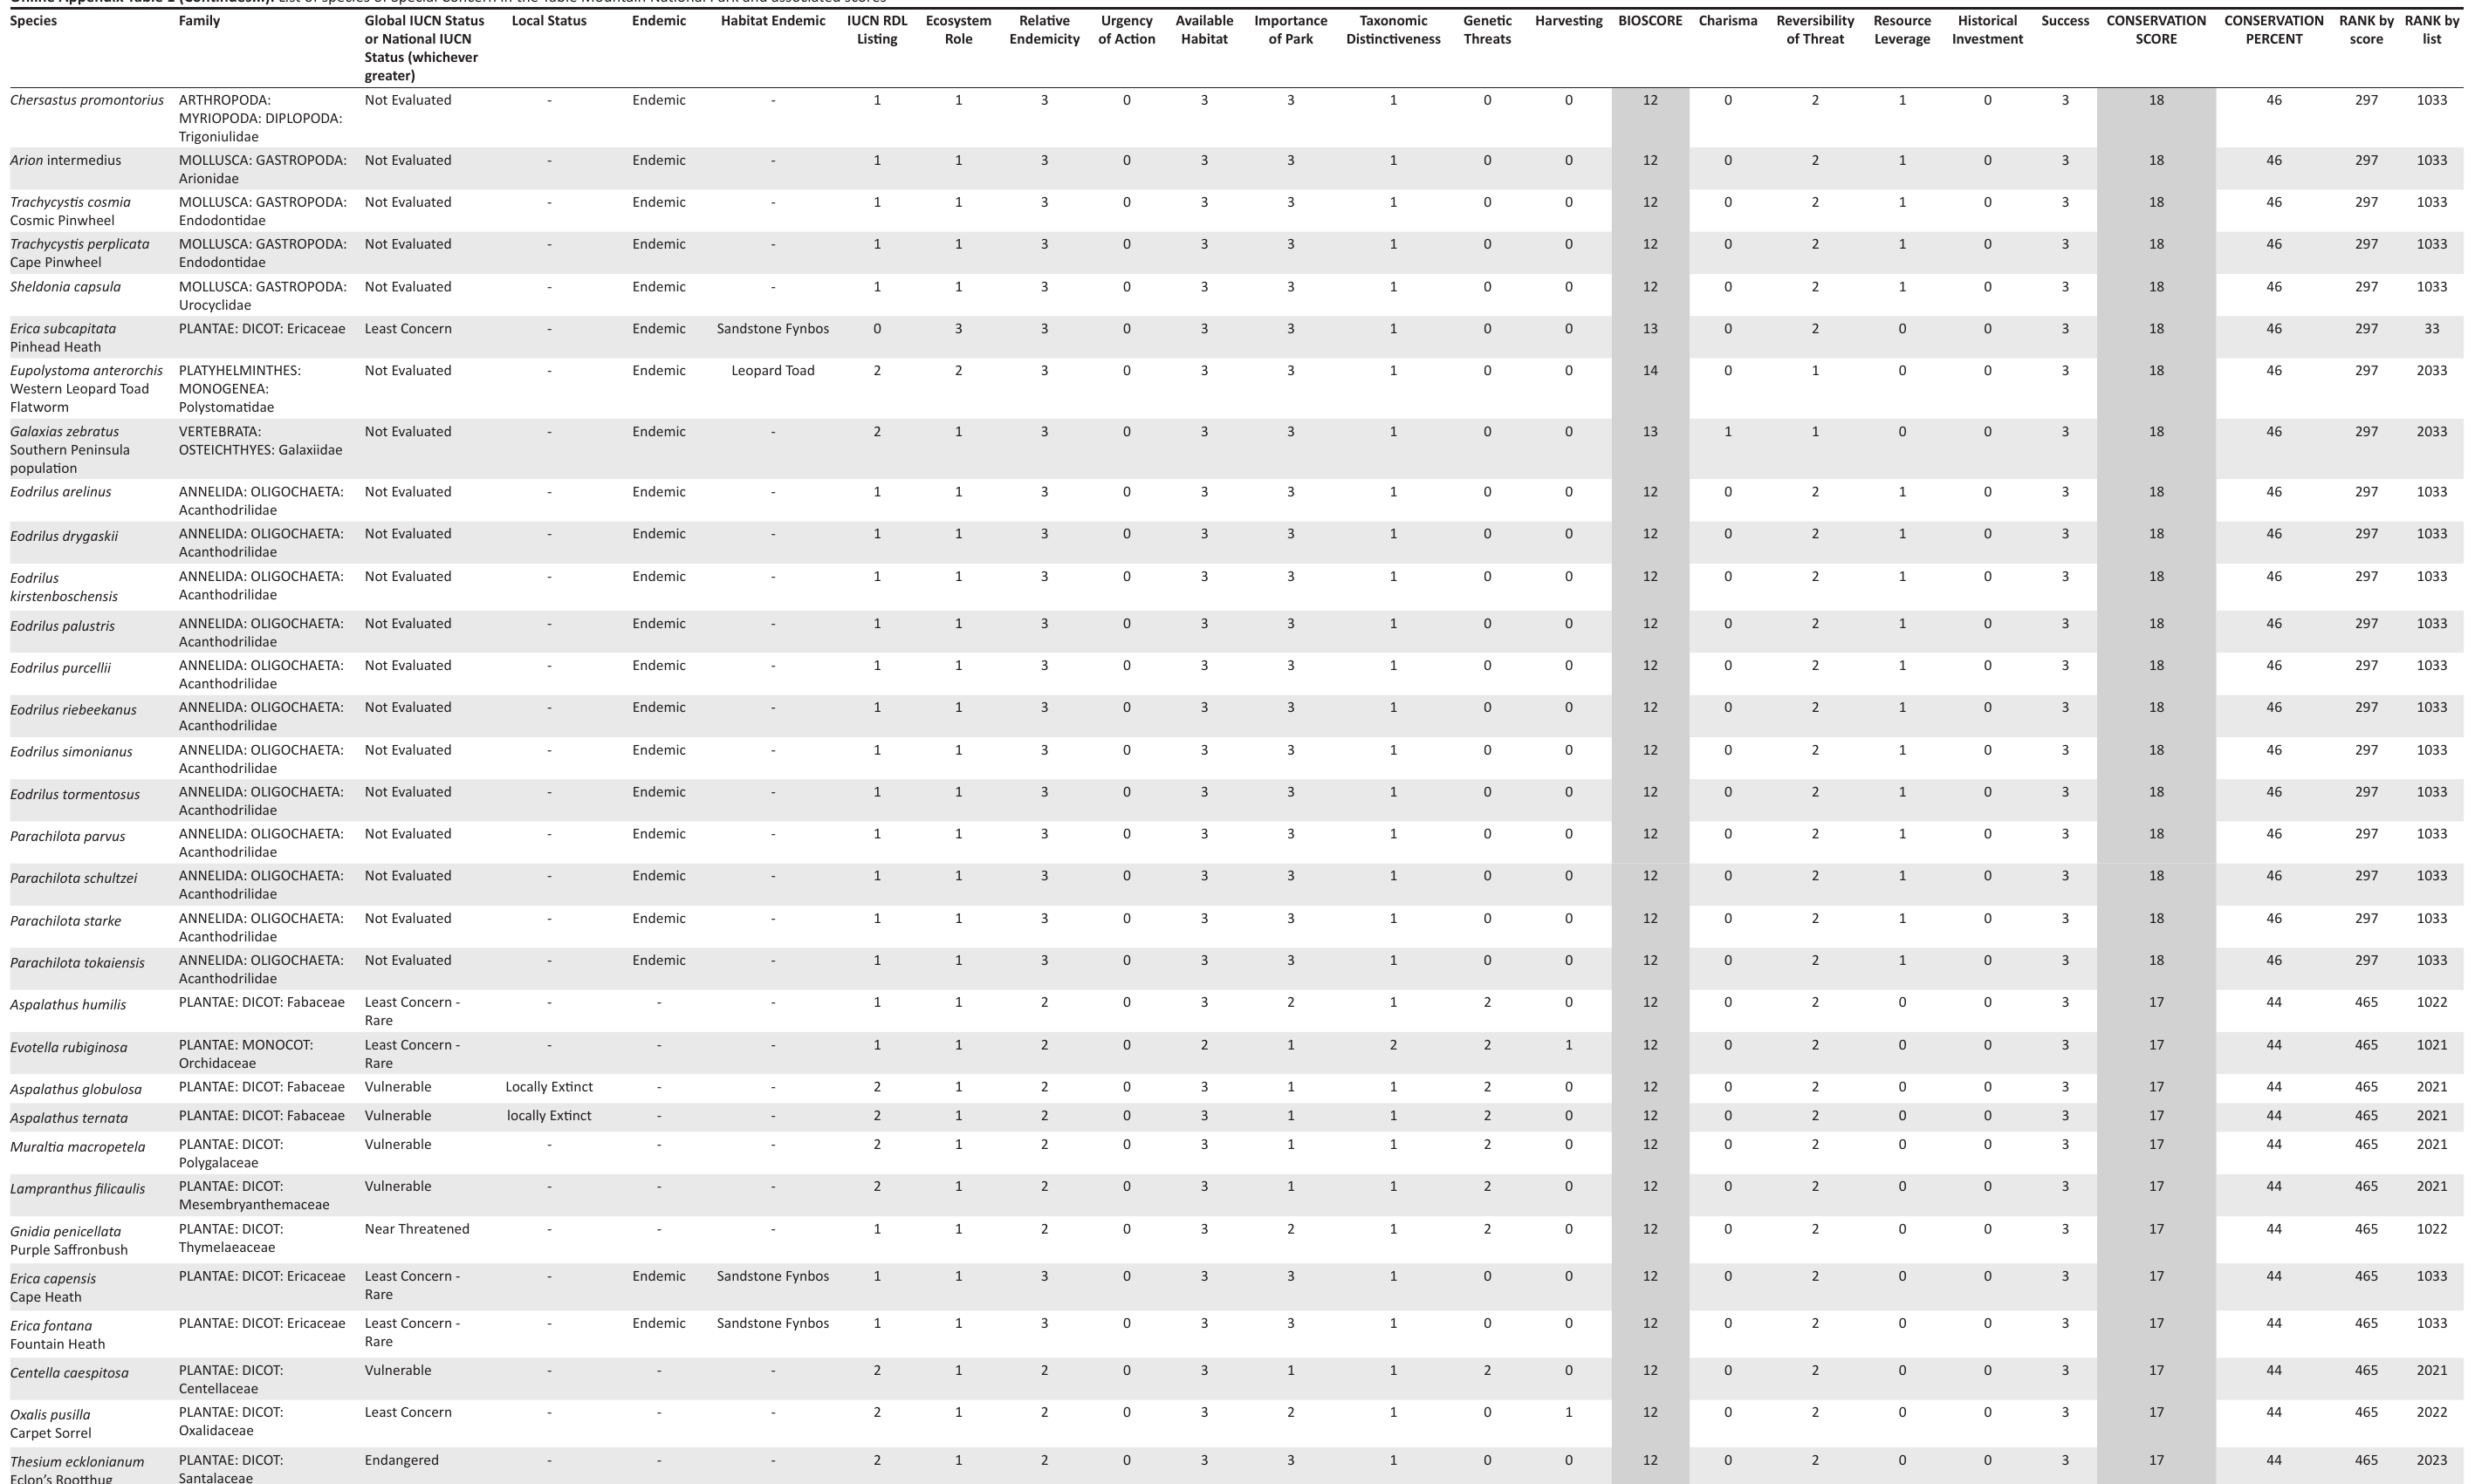
Online Appendix Table 1 (Continues...): List of species of Special Concern in the Table Mountain National Park and associated scores